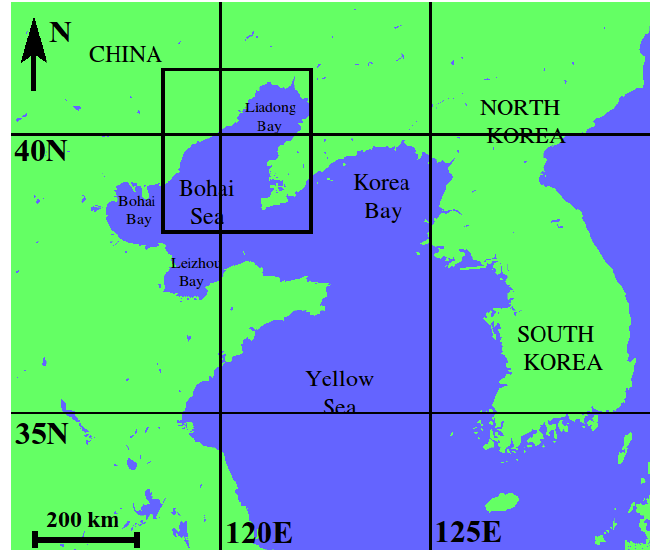
Figure 1. The study area in the Liaodong Bay, Northern Bohai Sea, indicated by the black frame